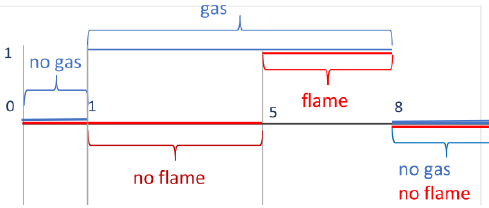
Figure 1. Gas- burner example.